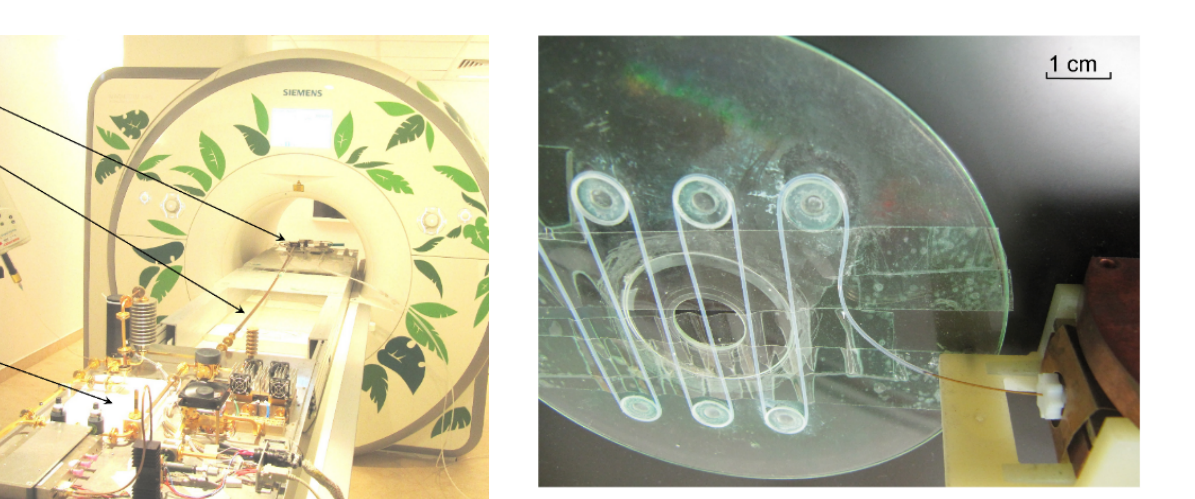
Figure 5. In-bore Overhauser DNP-MRI setup. 1 – mw resonator, 2 – waveguide between the mw resonator and the microwave board, 3 – syringe pump, 4 – microwave board.